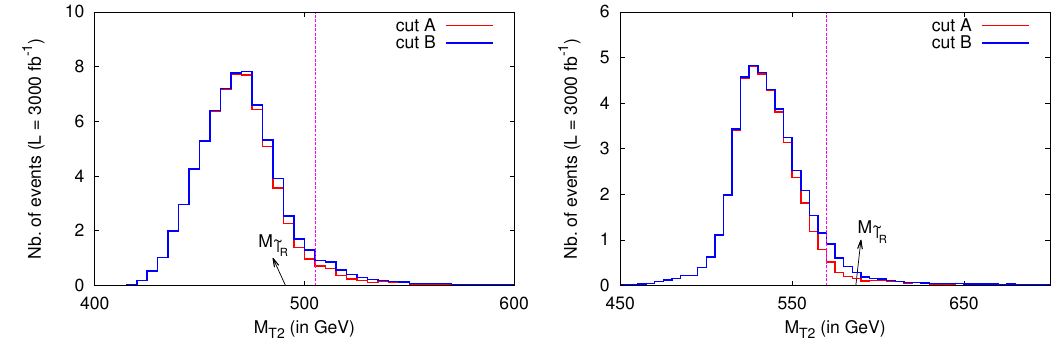
Figure 3 . M T 2 -distributions for BP1 (left) and BP4 (right) corresponding to m and m < m ~ (cid:22) respectively. The vertical dashed lines show the reconstructed slepton ~ (cid:31) 0 1 R ; ~ e R